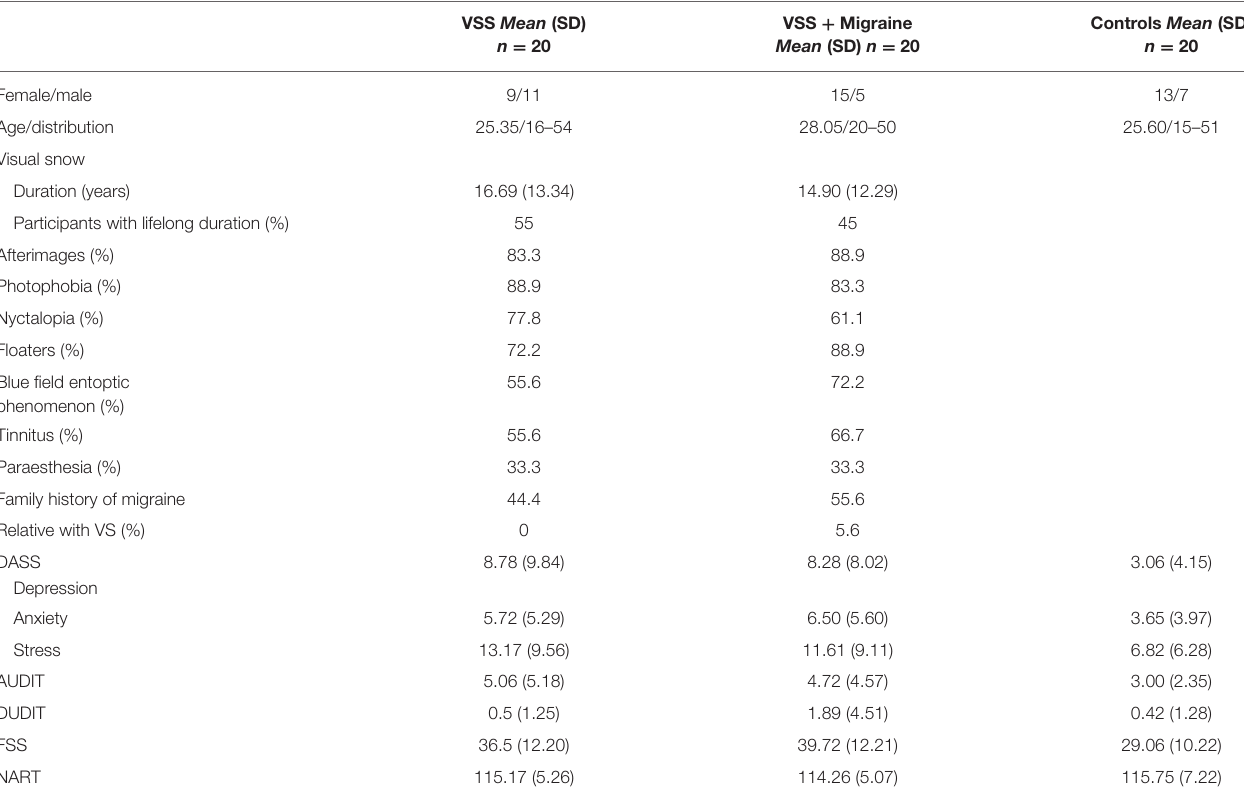
TABLE 2 | Demographic information for all participants.